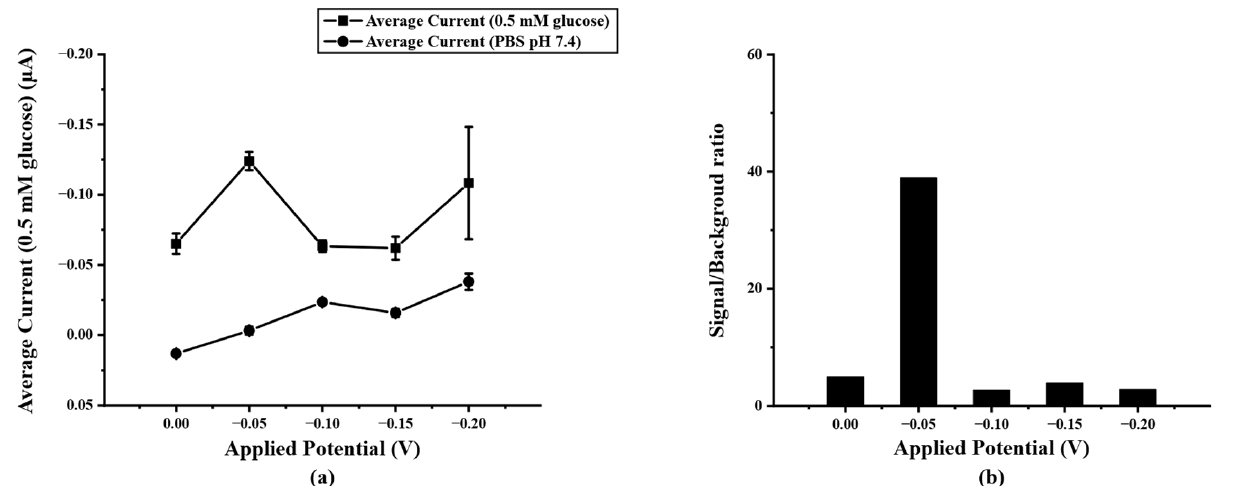
Figure 5. ( a ) current response of PB/Ti 3 C 2 T x /GOx/Nafion/SPIL-GE at different applied potential (0.0~ − 0.20 V vs Ag/AgCl) in 0.5 mM glucose, ( b ) S/B ratio at different applied potential according to the results in figure ( a ).